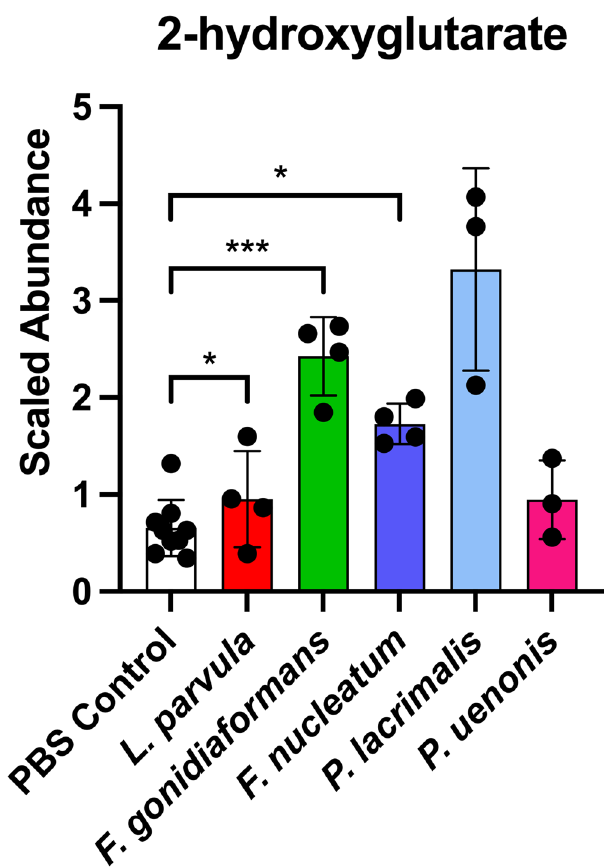
Fig. 5 Extracellular supernatants of 3-D cervical cells infected with L. parvula, F. gonidiaformans , and F. nucleatum infections accumulate the oncometabolite, 2-hydroxyglutarate. Scaled metabolite abundances of 2-hydroxyglutarate after 24 h infection with BVAB. * p < 0.05; *** p < 0.001. Student ’ s two-tailed paired t -tests. Error bars represent standard deviation. A minimum of n = 3 independent replicates were performed and measured for each